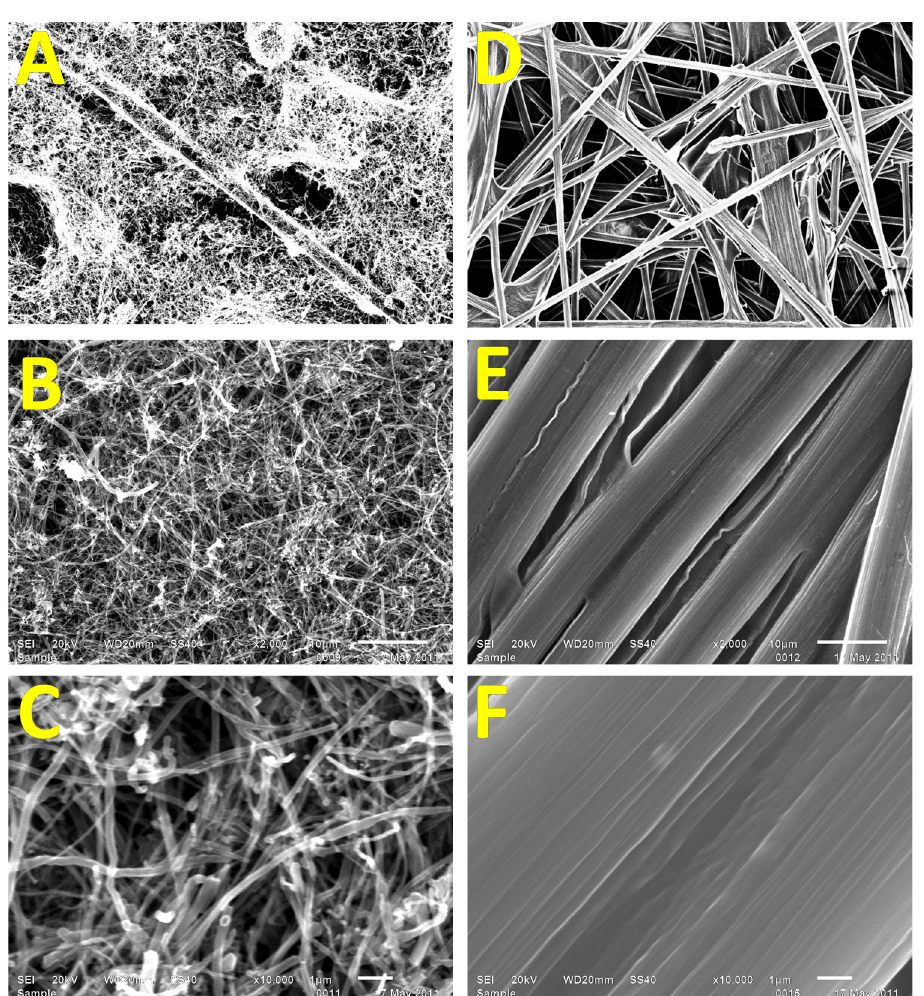
Figure 4. SEM images of increasing magnification (2000×, 5000×, and 10,000×) of pristine carbon nanofiber mats ( A – C ); and carbon microfiber paper ( D – F